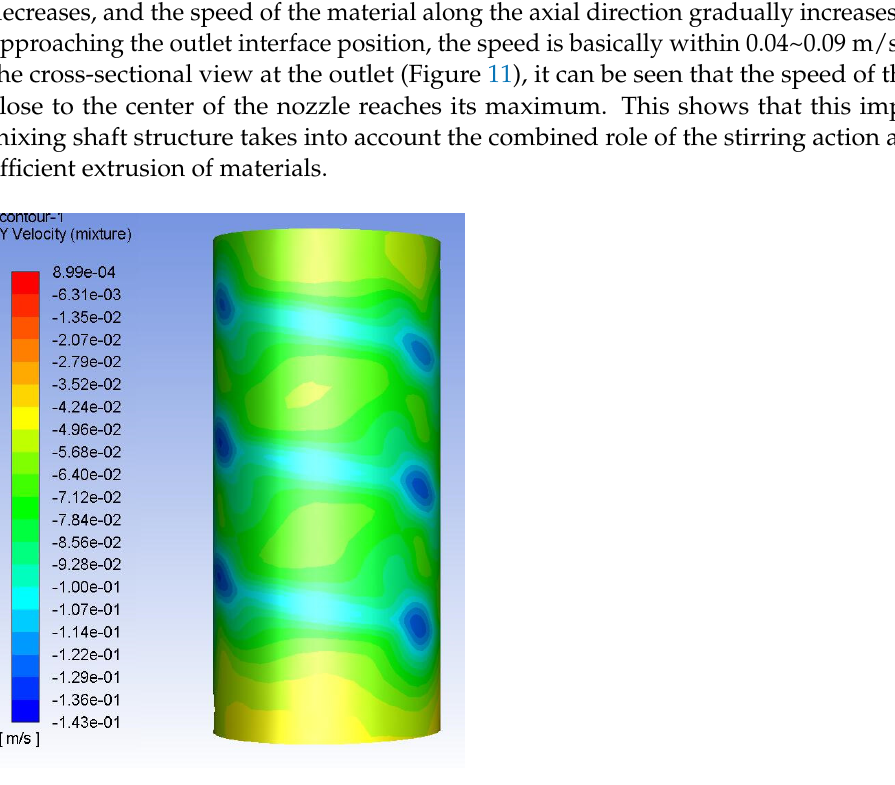
Figure 11. Velocity field simulation diagram at the bottom of the mixing cavity. 8. Experimental Analysis In order to verify the correctness of the above simulation, this paper produced a stir- ring shaft with a spoiler rod and a mixing chamber, formed a color printing nozzle, and built a multi-filament feed 3D printing experimental device, which used 5 wire feeders to